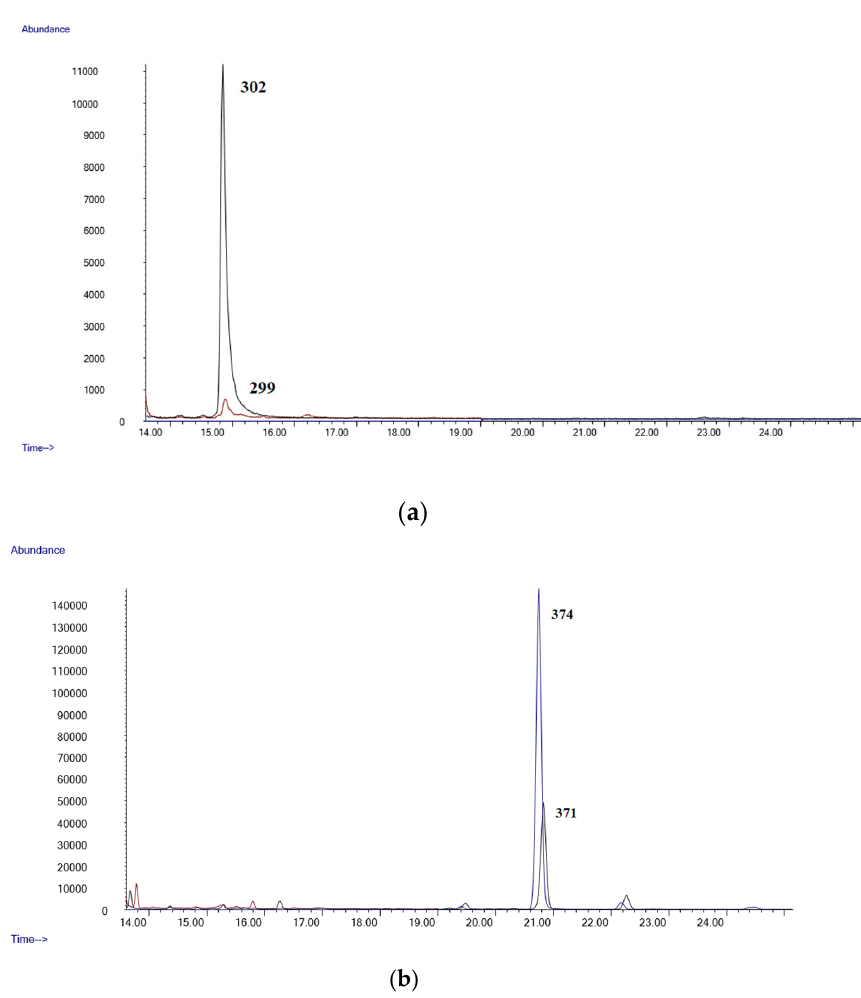
Figure 3. ( a ) Chromatogram of a postmortem blood sample (Case 25, Δ 9-THC: 0.11 µg/mL); ( b ) chromatogram of a postmortem blood sample (Case 25 Δ 9-THC-COOH: 1.77 µg/mL).